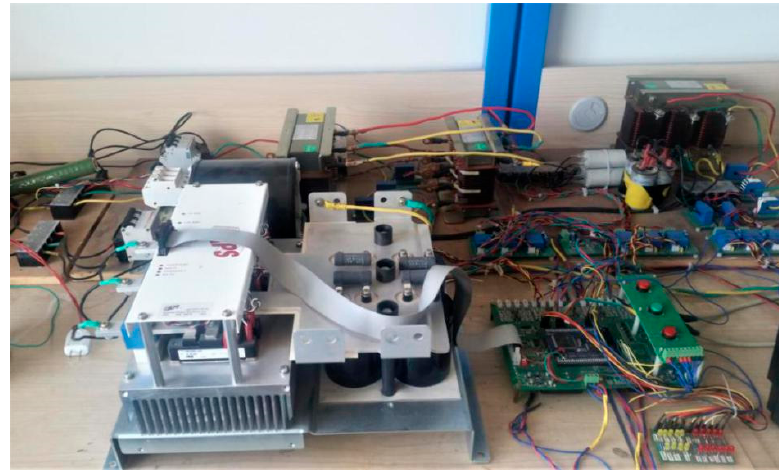
Figure 12. Experimental platform of SAPF with LCLCL filter.